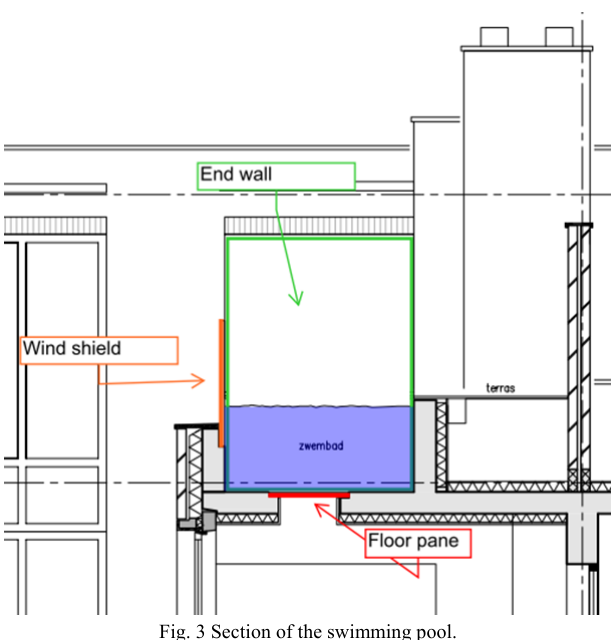
Fig. 2 900 Mahler overview.